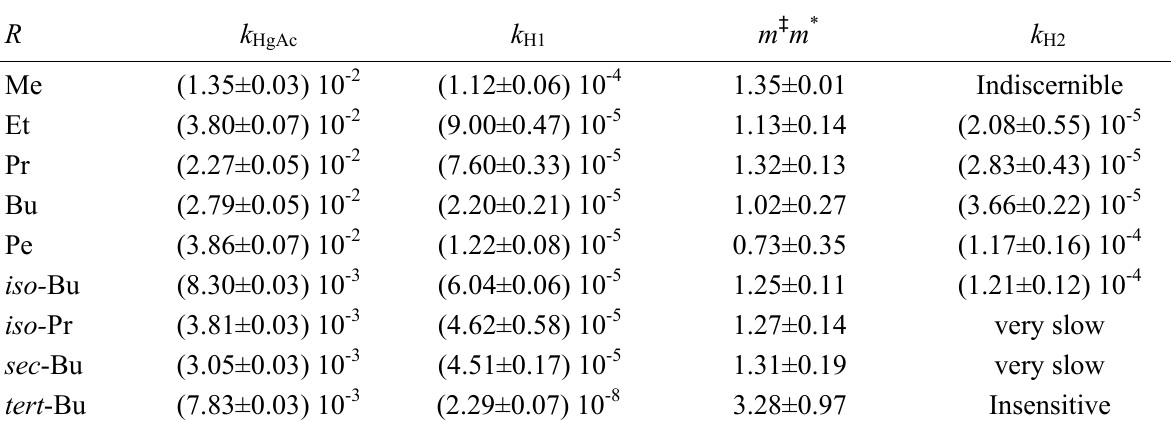
(dm 3 mol –1 s –1 HgAc